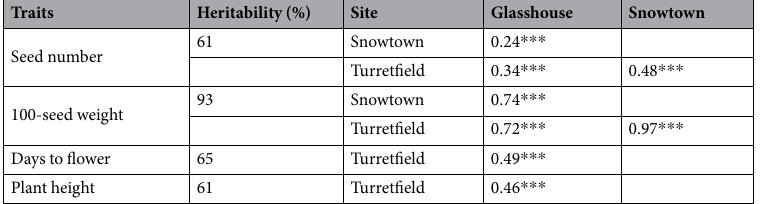
under non-saline conditions (Table 1; Figure S3). Salinity had a more detrimental effect on growth rate of ICC 2720 compared to ICC 95 (Fig. 2), two genotypes previously reported to contrast for salinity tolerance. On average salinity reduced shoot biomass and plant height at maturity by 28% and 15%, respectively, com- pared to non-saline condition (Table 1). Plants grown under saline conditions had greater leaf tissue damage,